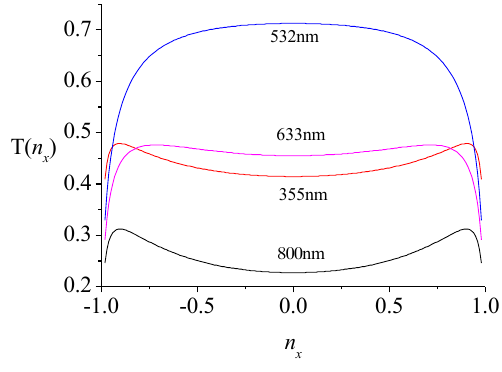
Figure 3. Angular dependence of the transmission coefficient for various wavelengths.